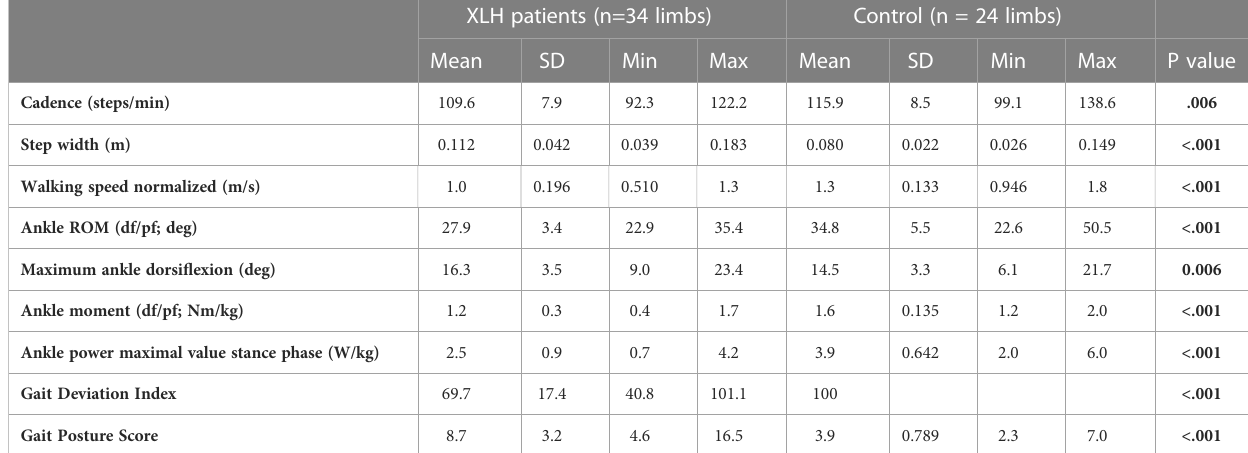
TABLE 2 Comparison for gait analysis data between XLH patients and the control group.